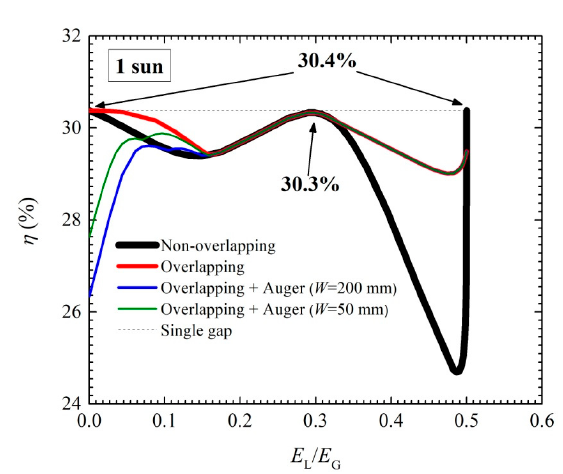
Figure 3. Limit e ffi ciency of silicon IBSC at one sun for di ff erent IB positions with and without overlapping and with and without Auger recombination (discussed in Section 3.3). The value of γ is optimized to maximize the e ffi ciency at every E L and the limit e ffi ciency of a conventional silicon solar cell is shown for